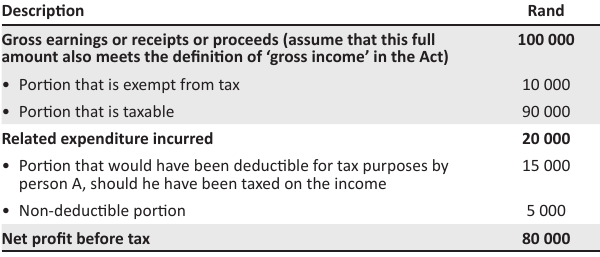
TABLE 1: Receipts or accruals and related